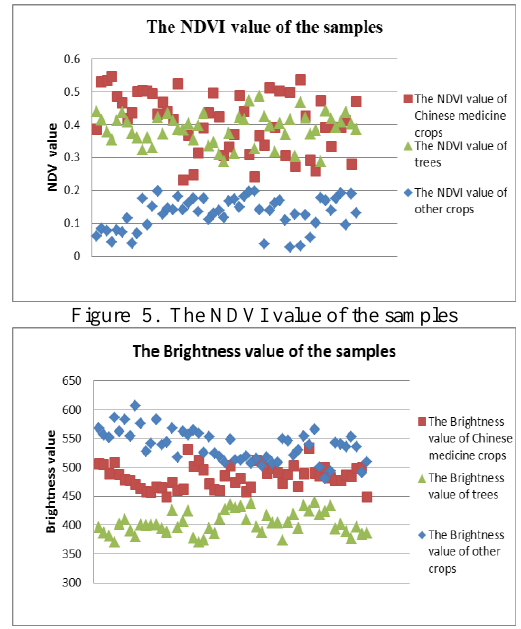
Figure 6.The Brightness value of the samples